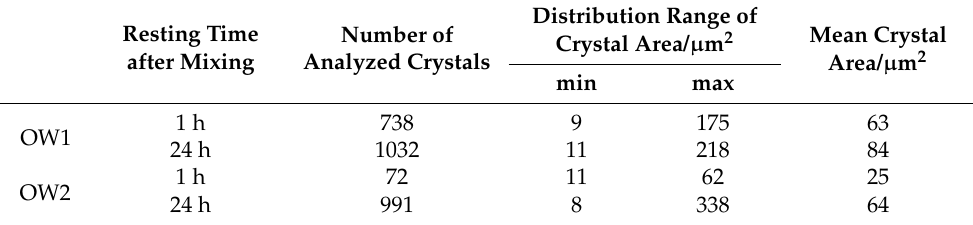
Table 3. Quantitative analysis of the area of the CaOx crystals visualized in the micrographs of the aqueous suspensions obtained by mixing the calcium chloride and sodium oxalate solutions, prepared using the oligomineral water